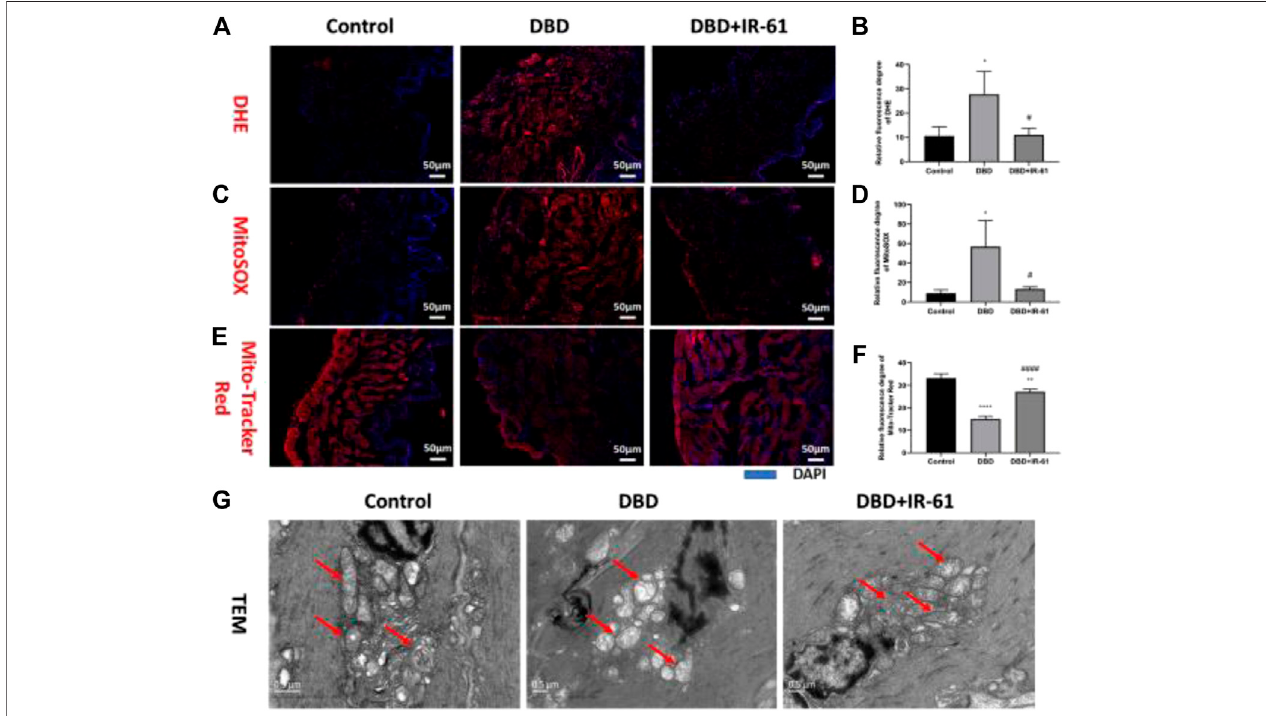
FIGURE 5 | IR-61 alleviated diabetes-induced oxidative stress in bladder tissues and damage to mitochondria in BSMCs. (A,B) Intracellular ROS in bladders detected by DHE staining of frozen bladder sections, scale bar (cid:2) 50 μ m. (C,D) Mitochondrial ROS in bladders detected by MitoSOX staining of frozen bladder sections, scalebar (cid:2) 50 μ m. (E,F) MitochondrialmassofBSMCsmeasured byMito-TrackerRedstainingoffrozen bladdertissuesections,scalebar (cid:2) 20 μ m. (G) Representative transmission electron micrographs of mitochondria morphology and structure in BSMCs. Red arrows indicate mitochondria, scale bar (cid:2) 0.5 μ m. Data indicate